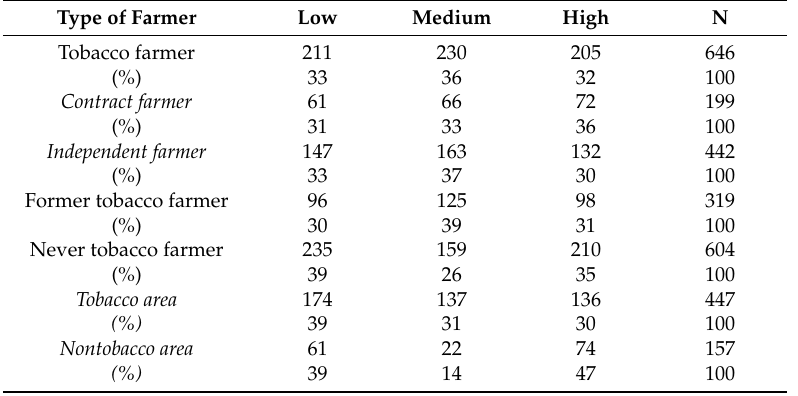
Table 3. Socioeconomic status of the sample households.